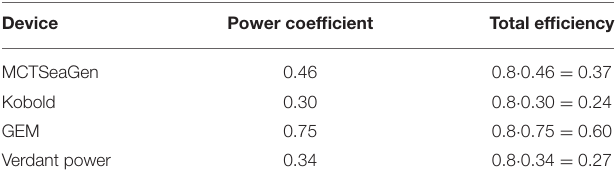
TABLE 1 | Power coefficient and total efficiency assumed for the selected current turbines.